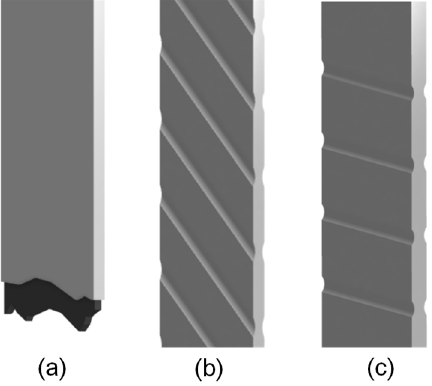
◦ fiber alignment, ( b ) 45 ◦ , ( c ) 90 ◦ .